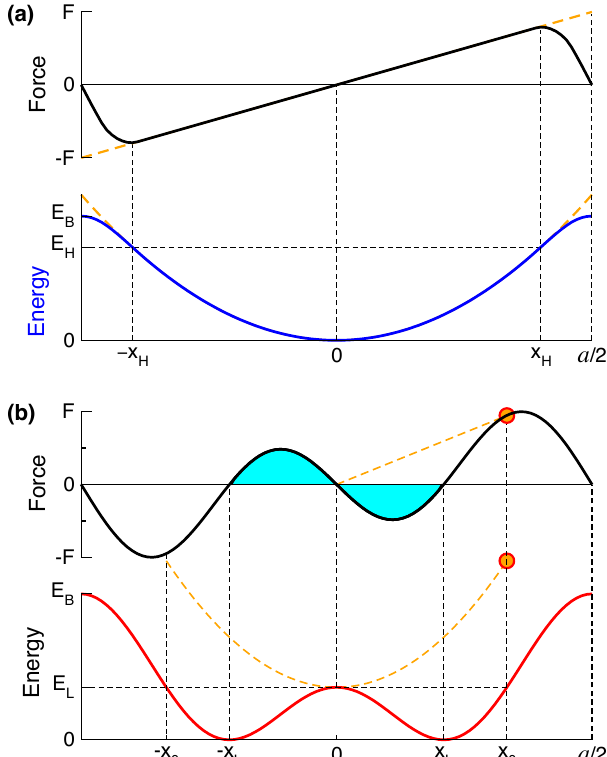
Figure 4. (color online) Potential energy E and force F = dE / dx versus displacement x (in arbitrary units) for a 1D crystal, which is either ( a ) harmonic for E < E H with N L = 1 (as in Figure 1a) or ( b ) anharmonic with N L = 2 (as in Figure 1b). For anharmonic case, forces at − x L < x < x L (shaded) push an atom away from the unstable equilibrium at x = 0, as F / x < 0. For kT > E L , the average atomic position is (cid:104) x (cid:105) = 0, and the effective linear force and harmonic potential at x 0 (filled circle) are shown (orange dashed lines).